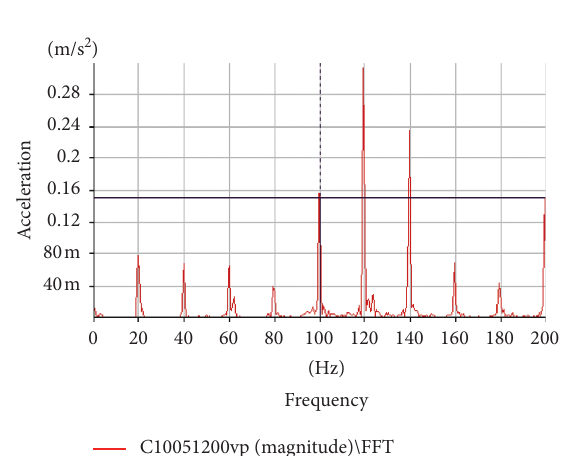
Figure 5: 0.1mm angular, 1200rpm.